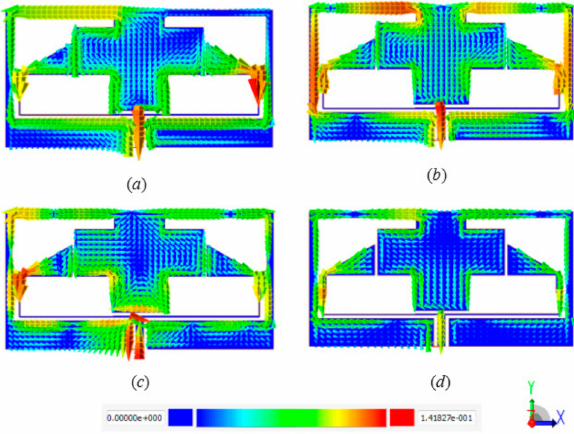
Figure 9. Simulated surface current intensity at: ( a ) 900; ( b ) 2.4; ( c ) 3.5; and ( d ) 5.5 GHz.